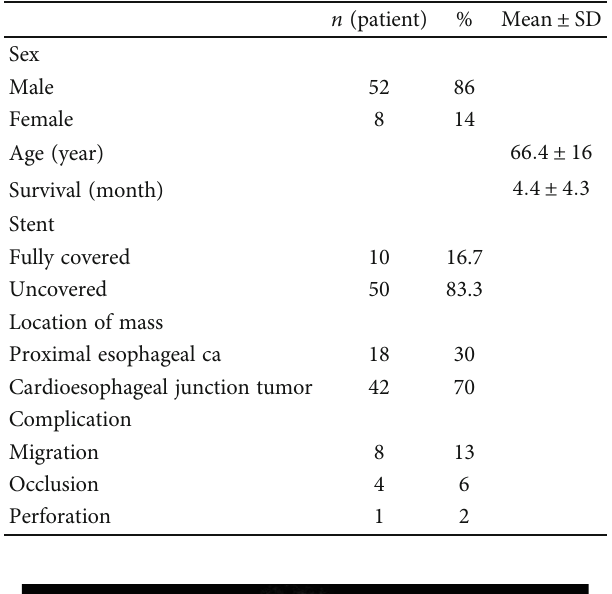
Table 1: Demographic characteristics of patients ( n = 60 ).